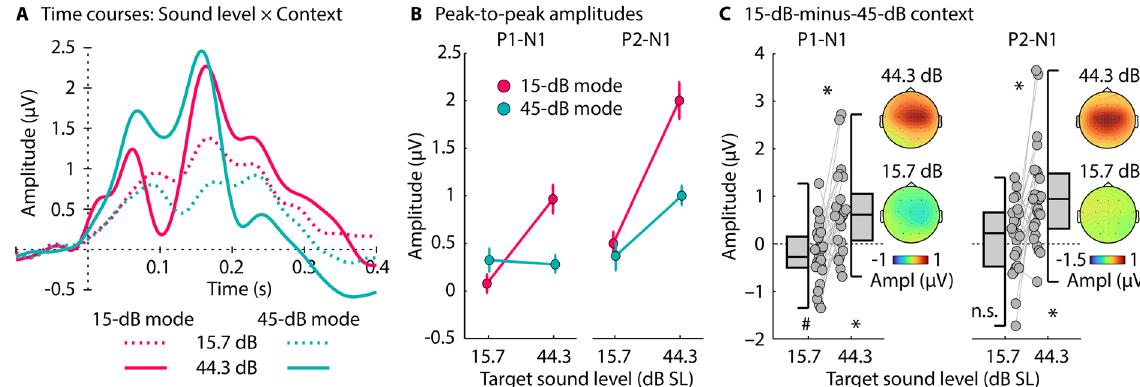
Figure 4. Neural responses to noise bursts in two different sound-level contexts. ( A) Response time courses (averaged across a fronto-central electrode cluster) for sound level × context conditions. ( B ) P1-N1 and P2-N1 peak-to-peak amplitudes for target-noise bursts with different intensities (one centered on 15.7 dB and one on 44.3 dB) for the 15-dB SL context and for the 45-dB SL context. Error bars reflect the standard error of the mean (removal of between-subject variance 67 ). The interaction between context and target-intensity category is significant for both P1-N1 and P2-N1 amplitudes (p < 0.05). ( C ) Amplitude difference between the 15-dB SL and 45-dB SL contexts, separately for low- and high-intensity targets. A positive value means a larger amplitude for the 15-dB SL compared to the 45-dB SL context, whereas a negative value means a larger amplitude for the 45-dB SL compared to the 15-dB SL context. Topographical distributions reflect the mean response difference between the two statistical contexts. #p ≤ 0.01, * p ≤ 0.05, n.s. – not significant.